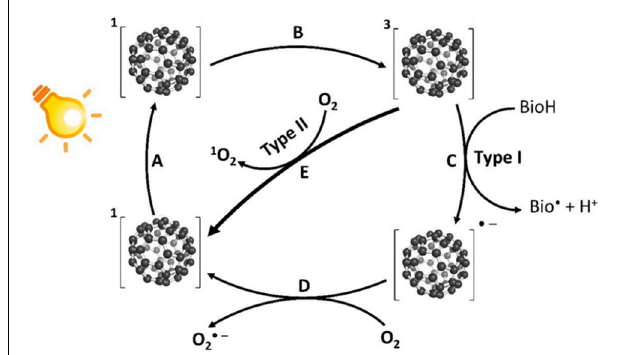
FIGURE 1 | Schematic representation of the photodynamic activities of fullerenes (Heredia et al., 2022). A: Photoexcitation of fullerenes to the singlet state; B: Transition from the singlet state to the triplet state by ISC; C: Charge transfer to surrounding biomolecules to form ROS (Type-I mechanism); D: Fullerenes can further transfer an electron to O 2 to form O 2 · - ; and E: Energy transfer from the excited triplet state to O 2 to form 1 O 2 (Type-II